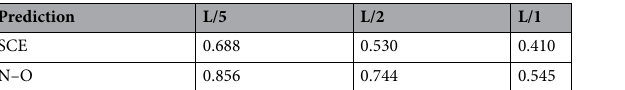
Table 5. Long range precision of prediction made for Side-Chain cEnters (SCE) contact and contact between the nitrogen and the oxygen (N–O) in peptide bonds. The contact is defined if as pairs within 8 Å for SCE- SCE, and 4 Å for N–O. The 43 CASP13 FM and FM/TBM targets were considered.